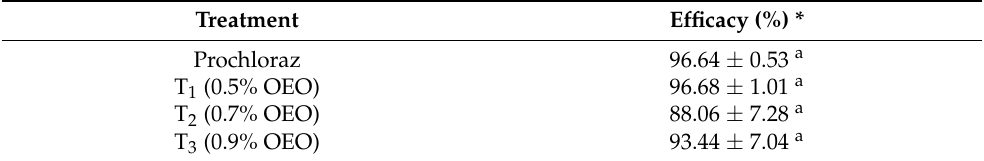
Table 2. Efficacy (%) of coatings with OEO for controlling C. gloeosporioides in mango cv. Tommy Atkins after 9 days of storage.